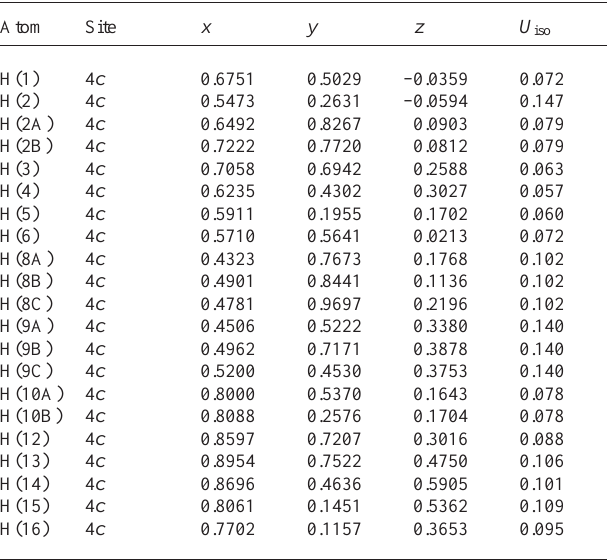
Table 2. Atomic coordinates and displacement parameters (in Å 2 )